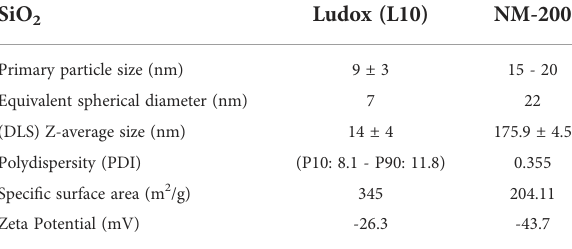
TABLE 1 Physical properties of amorphous silica